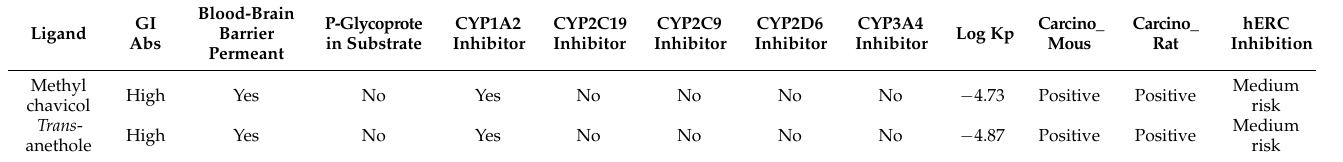
Table 11. Predicted pharmacokinetic and toxicological properties of methyl chavicol and trans